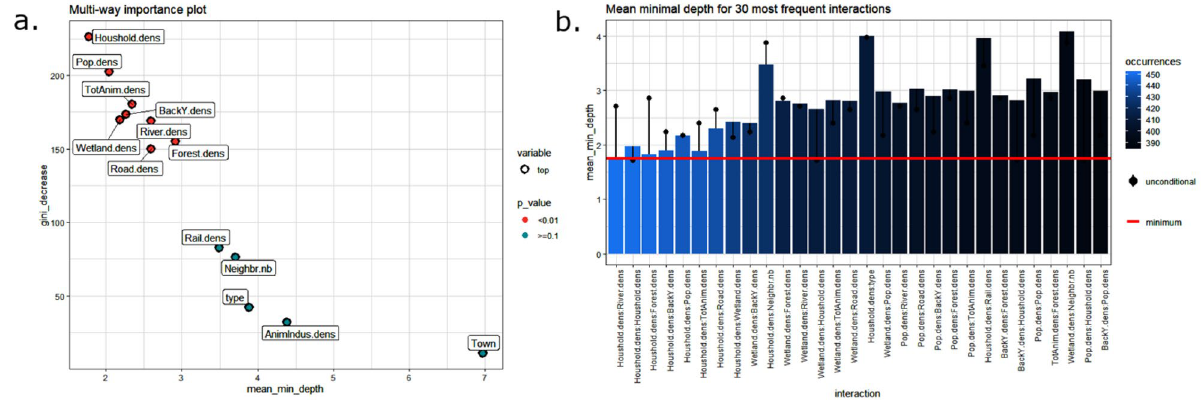
Figure 6. Random forest classification for the 14 spatiotemporal clusters of ASF in Romania. ( a ) Explanatory variable importance plot to differentiate clusters (N = 2895 cases, including 2322 pig holding outbreaks and 573 wild boar cases from June 10, 2018 to August 29, 2019). ( b ) Most frequent interactions between the eight significant explanatory variables explaining the 14 spatiotemporal clusters of ASF in Romania from June 10, 2018 to August 29, 2019 by means of a random forest classification. N = 2895 cases, including 2322 pig holding outbreaks and 573 wild boar